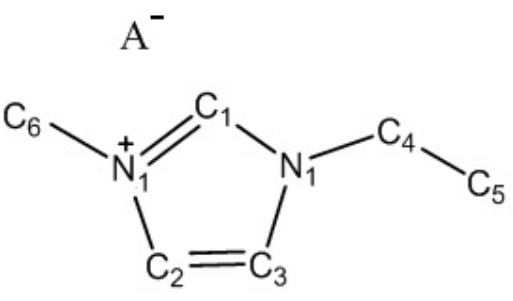
Figure 1. Notation of the carbon and nitrogen atoms of 1-ethyl-3-methylimidazolium (EMIm + ) cation. A − marks the Br − or BF 4 − anion,